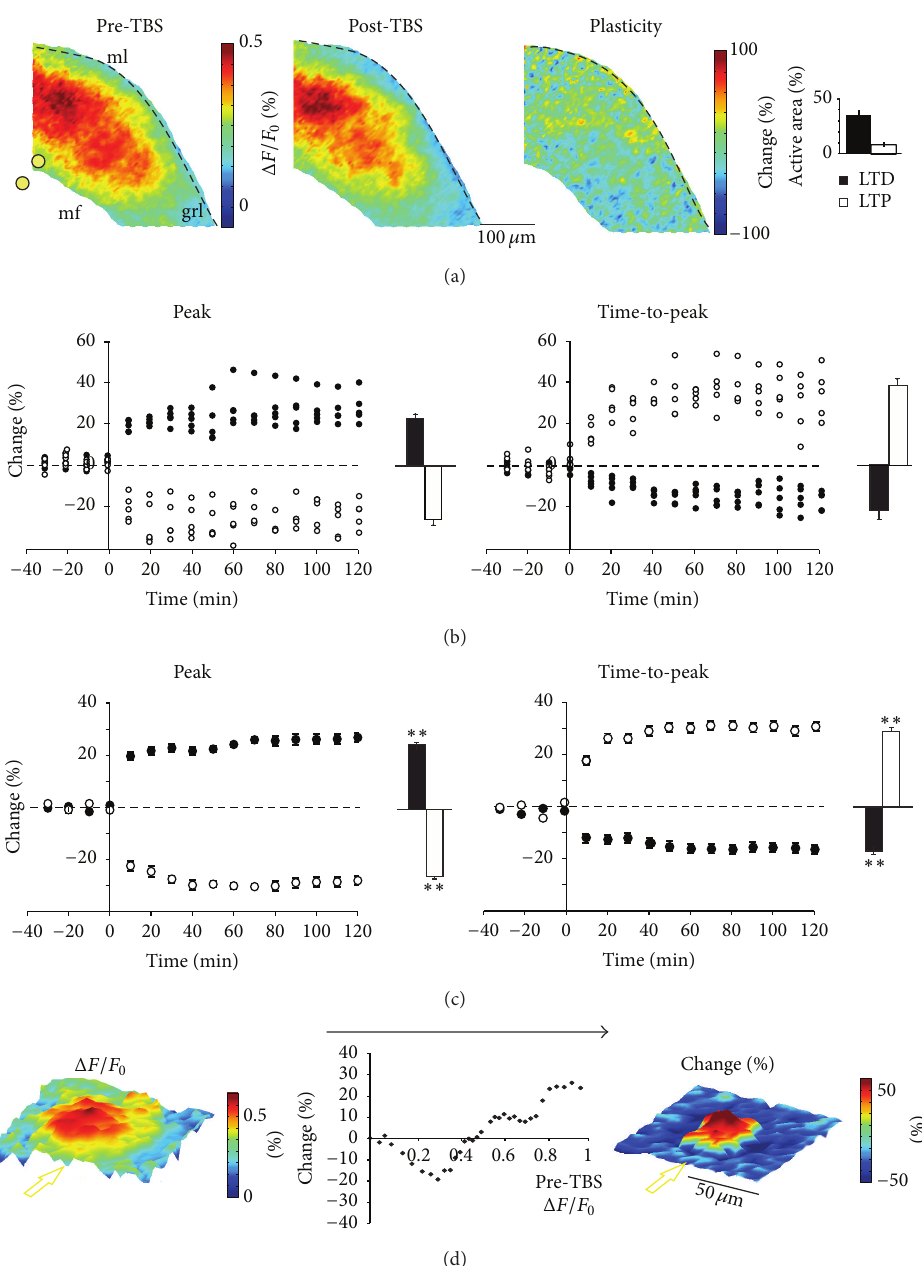
Figure 4: Properties of LTP and LTD. (a) Activation maps of the granular layer in response to a single pulse delivered to a mossy fiber bundle before ( left ) and after ( middle ) TBS. The distribution and intensity of the changes induced by TBS are shown in the subtraction map ( right ; see Section 2). The histogram shows the percentages of active pixels displaying LTP or LTD. (b) Time courses of VSD signal changes in five pixels showing LTP and five pixels showing LTD taken from the maps shown in (a). Pixels demonstrate stable responses in the control period and persistent variations of peak amplitude (left) and time-to-peak (right) after TBS. Note the inverse sign of the changes in the time course of peak amplitude and time-to-peak. The histograms show average changes in the 30–60 minutes after TBS compared to the control period. (c) Average time courses of all pixels showing LTP ( 𝑛 = 7 slices, 𝑛 = 2603 pixels) and LTD ( 𝑛 = 8 slices, 𝑛 = 10116 pixels) both for peak amplitude and time-to-peak. Histograms show average changes in the period 30–60 minutes after TBS compared to the control period. (d) Correspondence between theaverage center-surround map of VSD activation ( left ; 𝑛 = 8 slices and 7056 pixels) and plasticity ( right ; 𝑛 = 7 slices and 6174 pixels) (the maps were generated by centering over pixels showing maximal response or maximal LTP and realigning the slices along the mossy fiber bundle indicated by the yellow arrow; see Section 2). The plot ( center ) shows the relationship between excitation measured as initial VSD amplitude and relative changes following TBS (the data were obtained only from pixels displaying significant and persistent